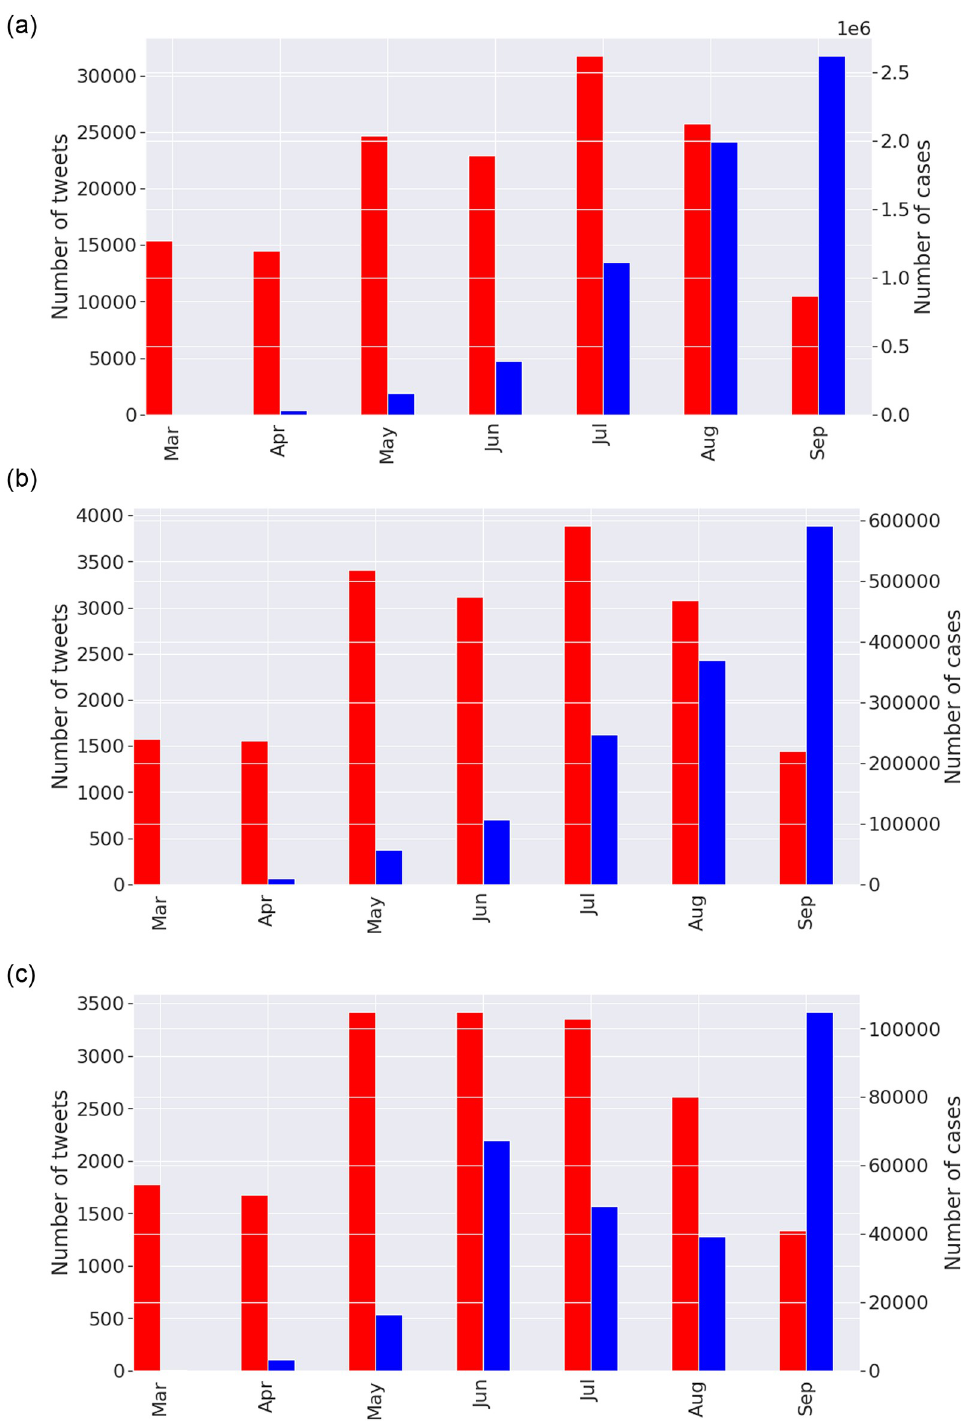
Fig 2. Novel COVID-19 tweets and cases in India, Maharashtra, and Delhi. The red bars indicate the number of tweets while the black bars indicate the number of novel cases.